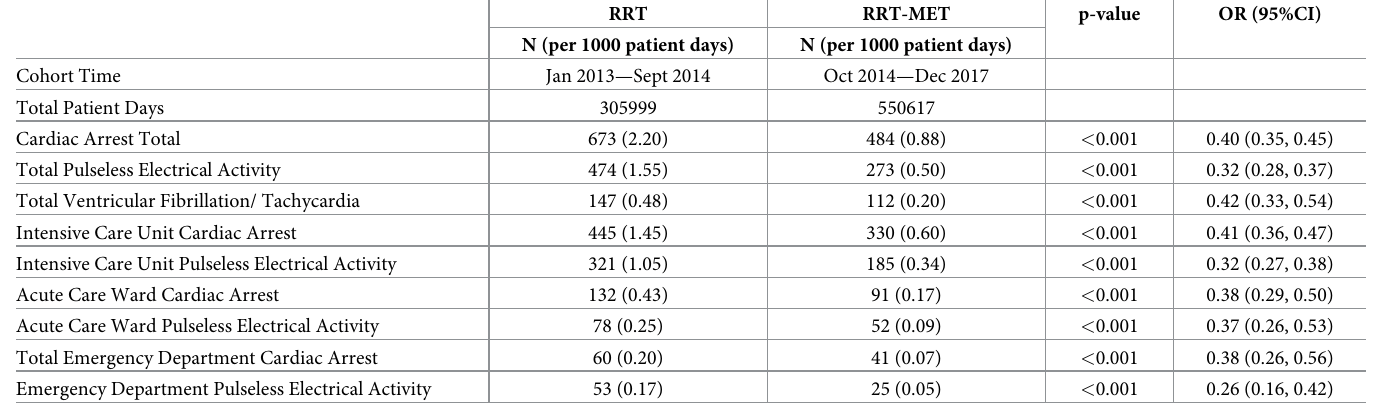
Table 2. Study outcomes before and after